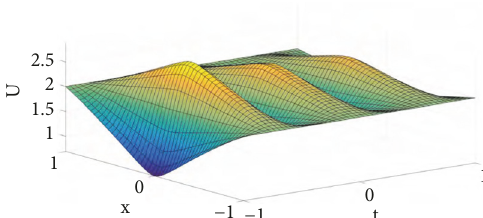
Figure 10: Quasistatic solution to the thermal problem 𝑢(𝑥,𝑡) .